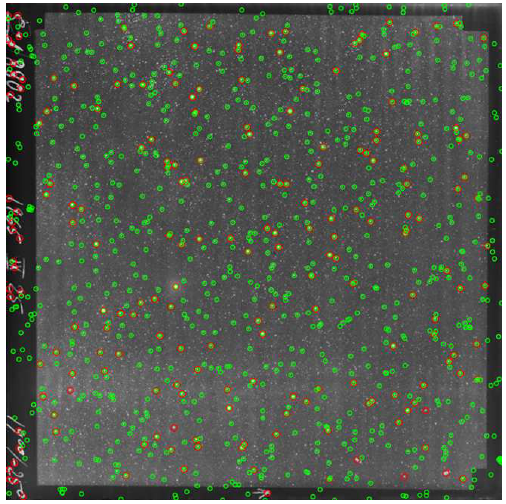
Figure 2: Example of digitized Bamberg southern sky patrol plate processed by astrometry.net tools: star